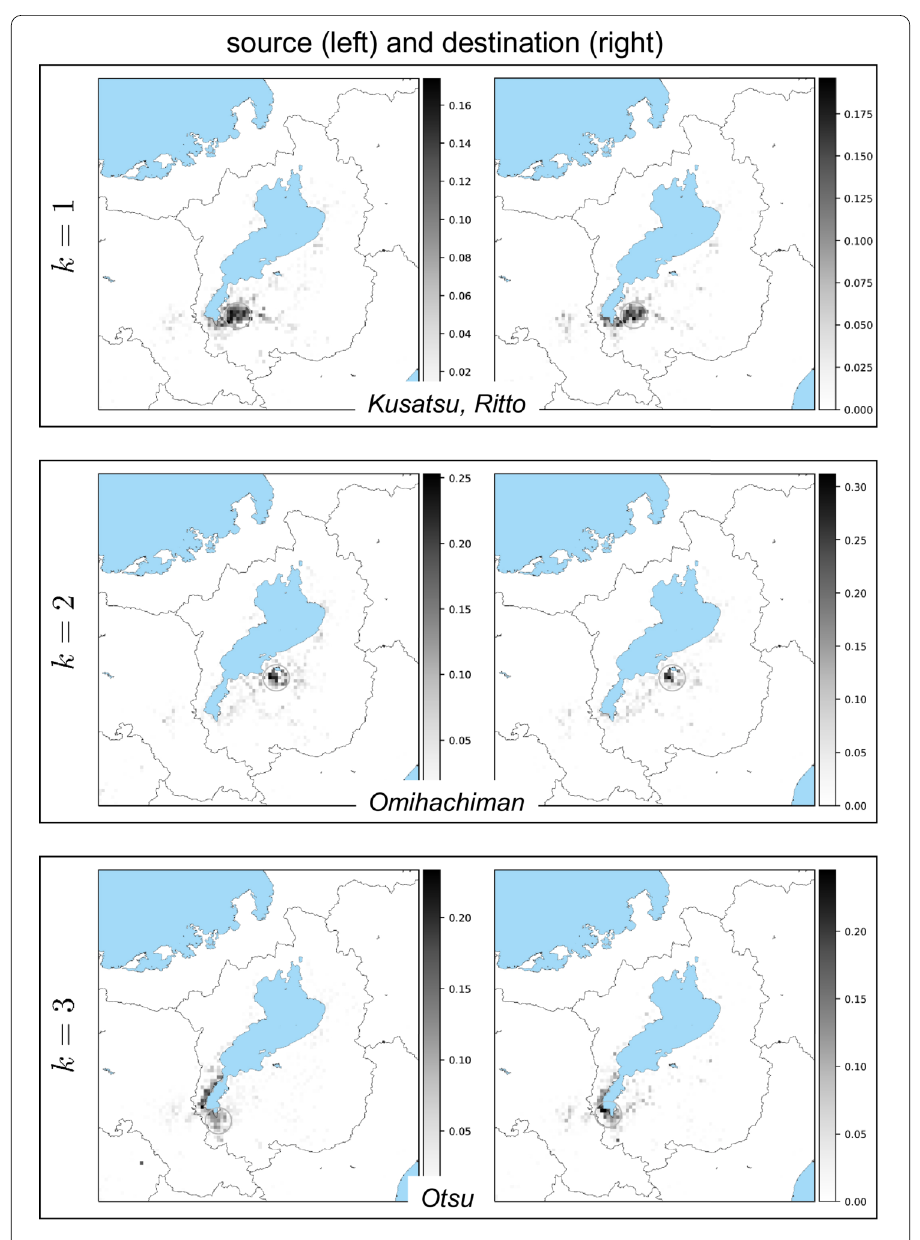
Figure 11 Each box shows a pair of NMF basis vectors w k (left) and h k (right). From top to bottom: k = 1,2,3. In each box, the left figure shows the vector components of w k mapped onto a geographical map (lake and sea shown in blue), which represent how sources of the k th NMF component are distributed spatially, while the right figure shows the components of h k , which represent how destinations of the k th NMF component are distributed spatially. The grayscale colorbar in each figure indicates magnitudes of the corresponding basis vector’s components after normalizing the vector by its Euclidean norm. Also shown in each figure is a small circle which corresponds to the maximum vector component. City name in each box was identified with the location of the circle